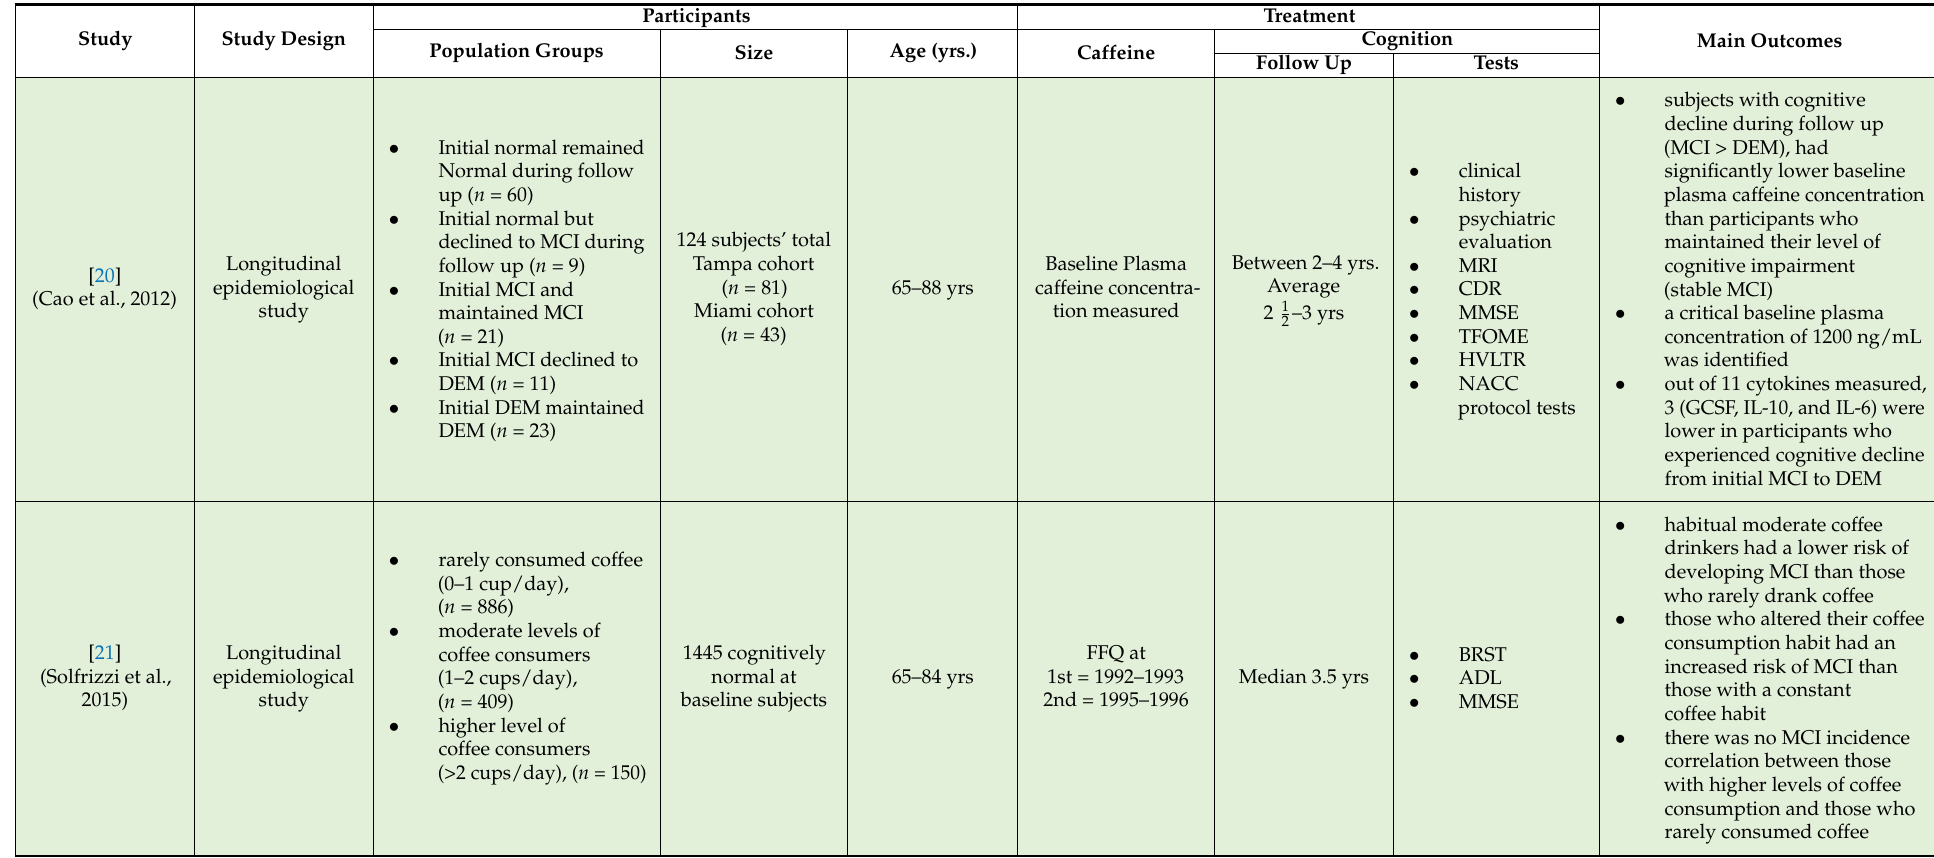
Table 1. Overview of clinical studies that investigates the relationship of caffeine and cognition in